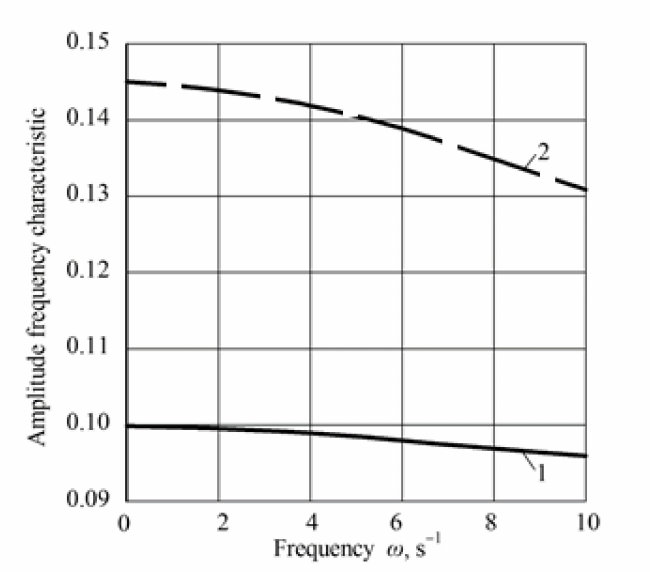
Figure 7. Amplitude-frequency characteristic of the tractor course angle ϕ when working out disturbances in the form of oscillations of the harvester machine rotation angle β at different values of the input resistance coefficient k B of pneumatic tires of rear traction wheels: 1–150 kN · rad − 1 ; 2–90 kN · rad − 1